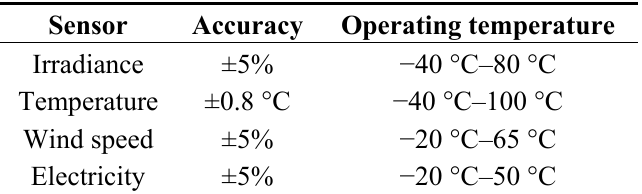
Table 5. Relative errors of the